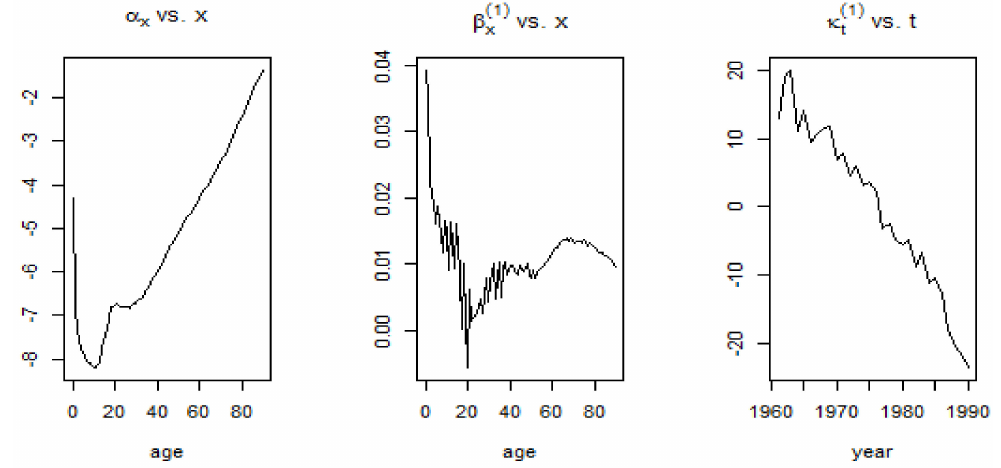
Figure 13. Estimation of the Lee-Carter parameters for the 1961–1990